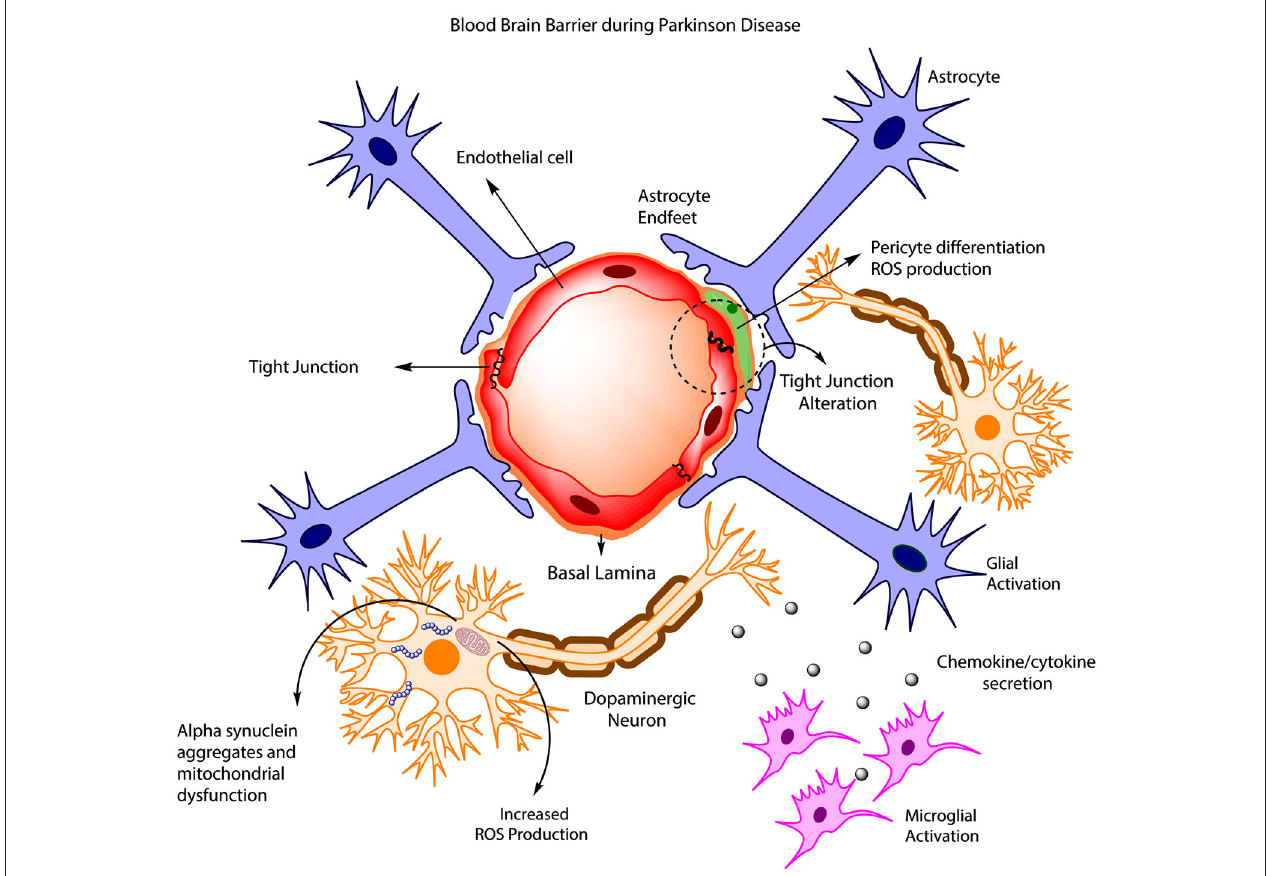
Concurrently, astrocyte and microglia became activated, promoting cytokine release, which in turn affects endothelial tight junctions, pericyte phenotype and BBB